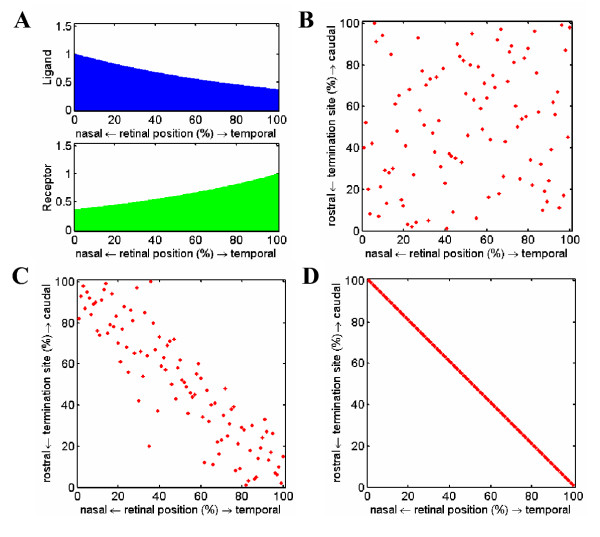
Typical solutions of 1D model A. Distribution of ligand (top) and receptor (bottom). B. Solution of the model for α = 0. Red dots represent terminal positions of individual axons, originating at various points in retina. If the case α = 0 the map is completely random, since all the chemical cues are multiplied by zero in Eq. (1), and, therefore, cannot contribute to the solution. D. α is very large. Solution represents perfect ordering of axons in SC in the order of increasing density of receptor. This is because the chemical cues are extremely strong in this case, much stronger than noise. C. α = 30. At the intermediate value of α solution is a compromise between chemical signal and noise.